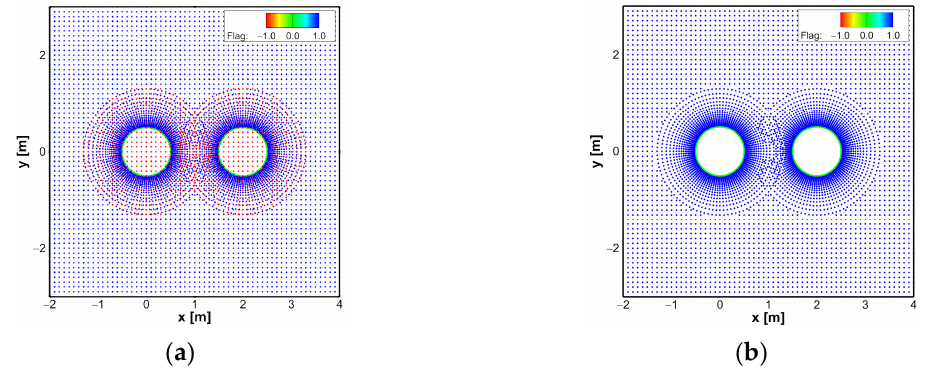
Figure 15. Distribution of computational points near a body ( a ) with and ( b ) without inactive points at a spacing ratio of 2.